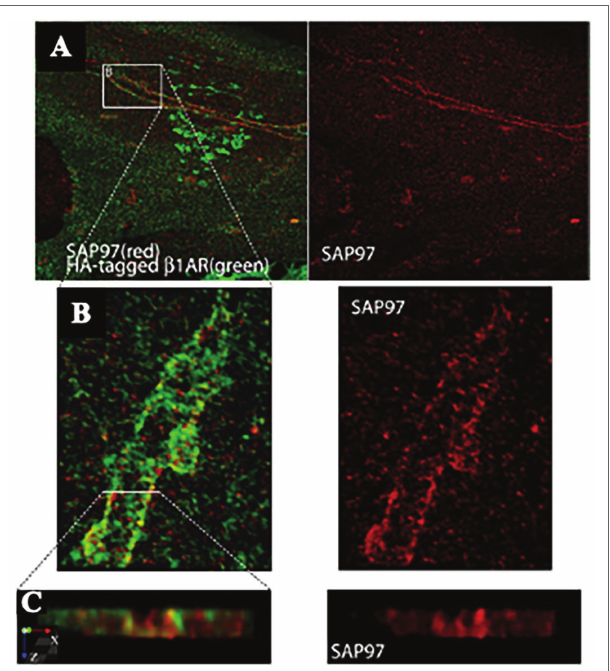
FIGURE 4 | SAP97 and β 1-ARs localize to cardiac sympathetic synapses in vitro . (A) CMs were cocultured with SNs for 7 days, infected with recombinant adenovirus expressing HA-tagged β 1-AR, and cultured for an additional 24 h before immunostaining for HA (green) and SAP97 (red). Two-photon image. (B,C) Enlargements of the boxed area in (A) . Modified with permission from Shcherbakova et al.